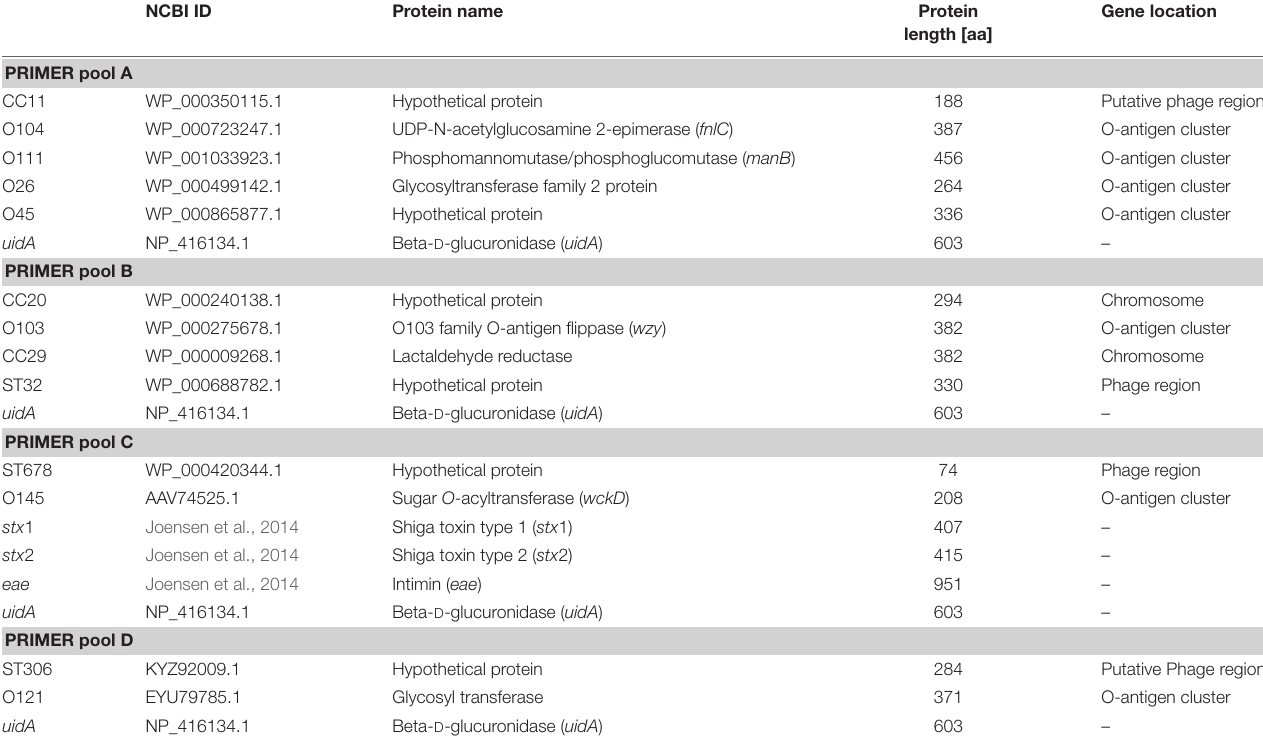
TABLE 5 | Protein function of